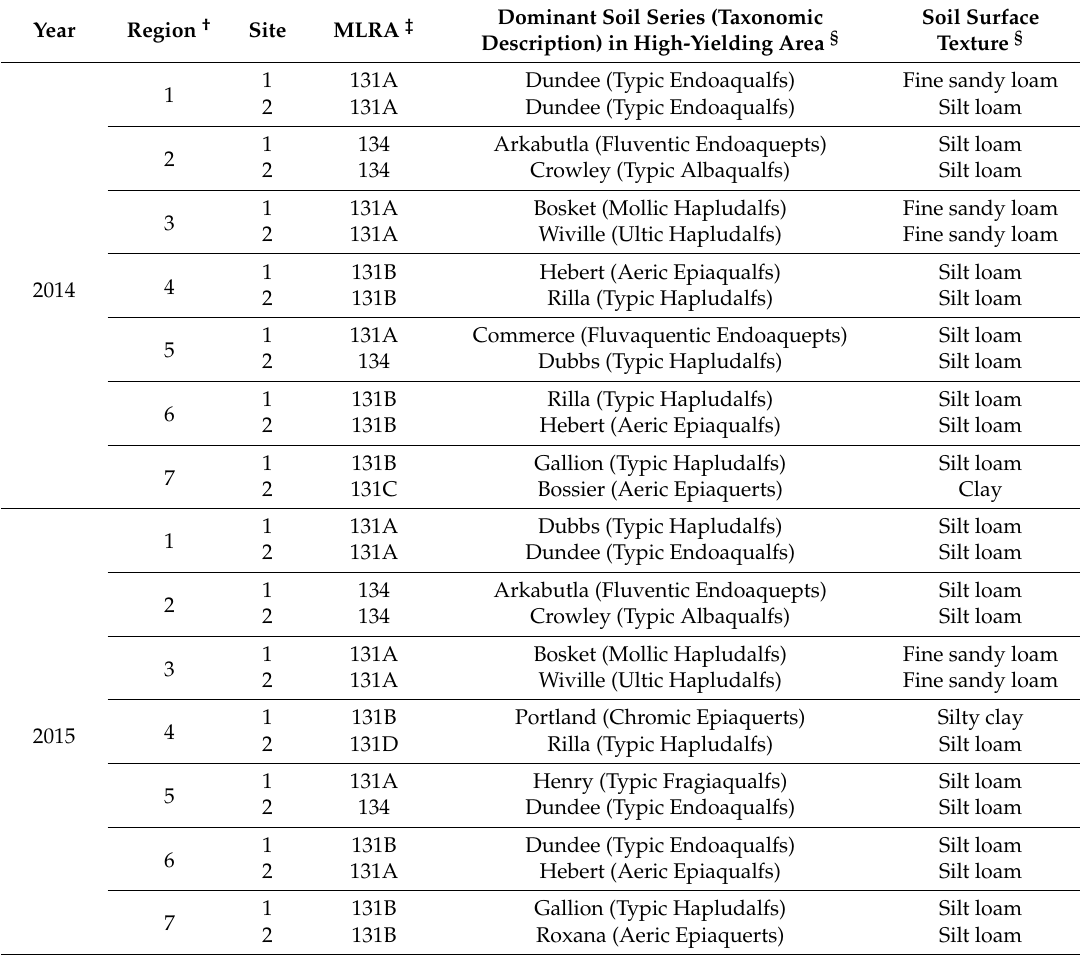
Table 1. Summary of participating grower sites in the 2014 and 2015 “Grow for the Green” yield contest sponsored by the Arkansas Soybean Promotion